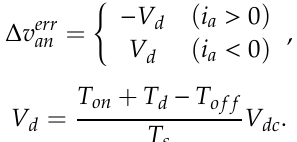
Figure 2. E ff ects of the dead-time in Figure 1a ( f sw = 20 kHz, V dc = 100 V, L s = 0.01 mH, R s = 10 Ω ); Figure 2. Effects of the dead-time in Figure 1a ( ( a ) an a-phase pole voltage reference as space vector PWM (SVPWM); ( b ) comparing dead-time e ff ects Ω ); ( a ) an a-phase pole voltage reference as space vector PWM (SVPWM); ( b ) comparing dead-time with equal voltage reference with ( a effects with equal voltage reference with (a).